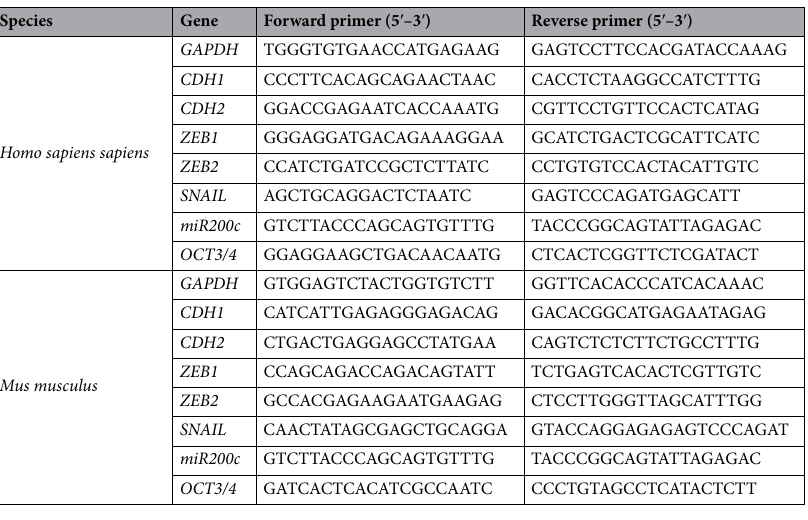
Table 1. Primer sequences for